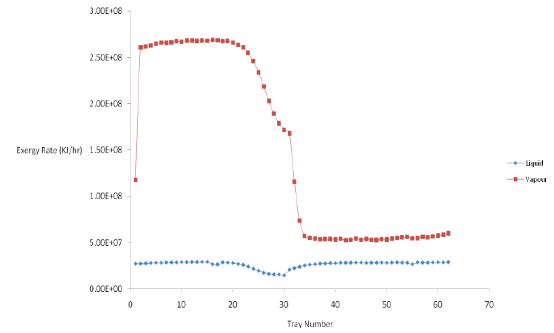
Figure 6. Profile of exergy rate versus tray number the for debutanizer of the Base Case